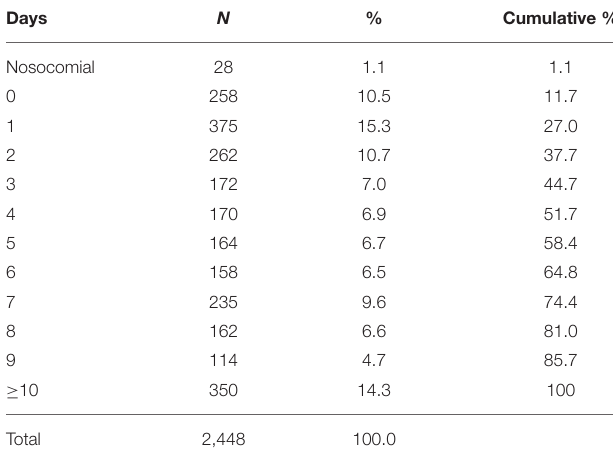
TABLE 2 | Days from symptoms onset to hospital admission, including in nosocomial cases.